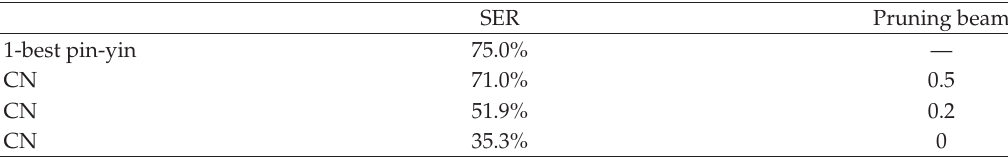
Table 1: SER of CN and 1-best pin-yin sequence.